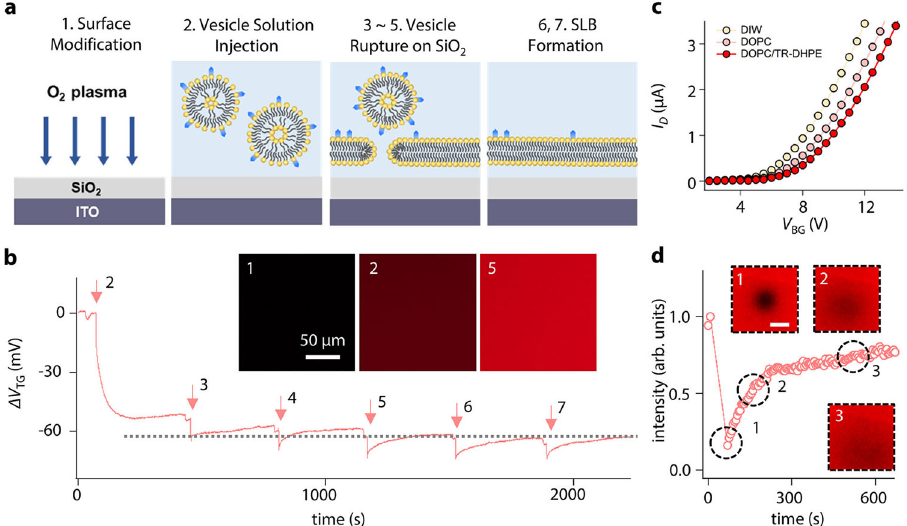
Fig. 2 SLB formation and its time-dependent measurement. a Schematic illustration of SLB formation. b Real-time tracing during an SUV rupture process. Insets show fl uorescent images of the EG after SLB formation at different vesicle concentrations; (marker 1) after O 2 plasma treatment, (marker 2) at 1 μ g mL − 1 , and (marker 6) at 5 μ g mL − 1 . c I D – V BG curves with different ingredients in the SLB. d Time-dependent FRAP measurement. The scale bar in the inset is 50 μ m. Source data are provided as a Source Data fi